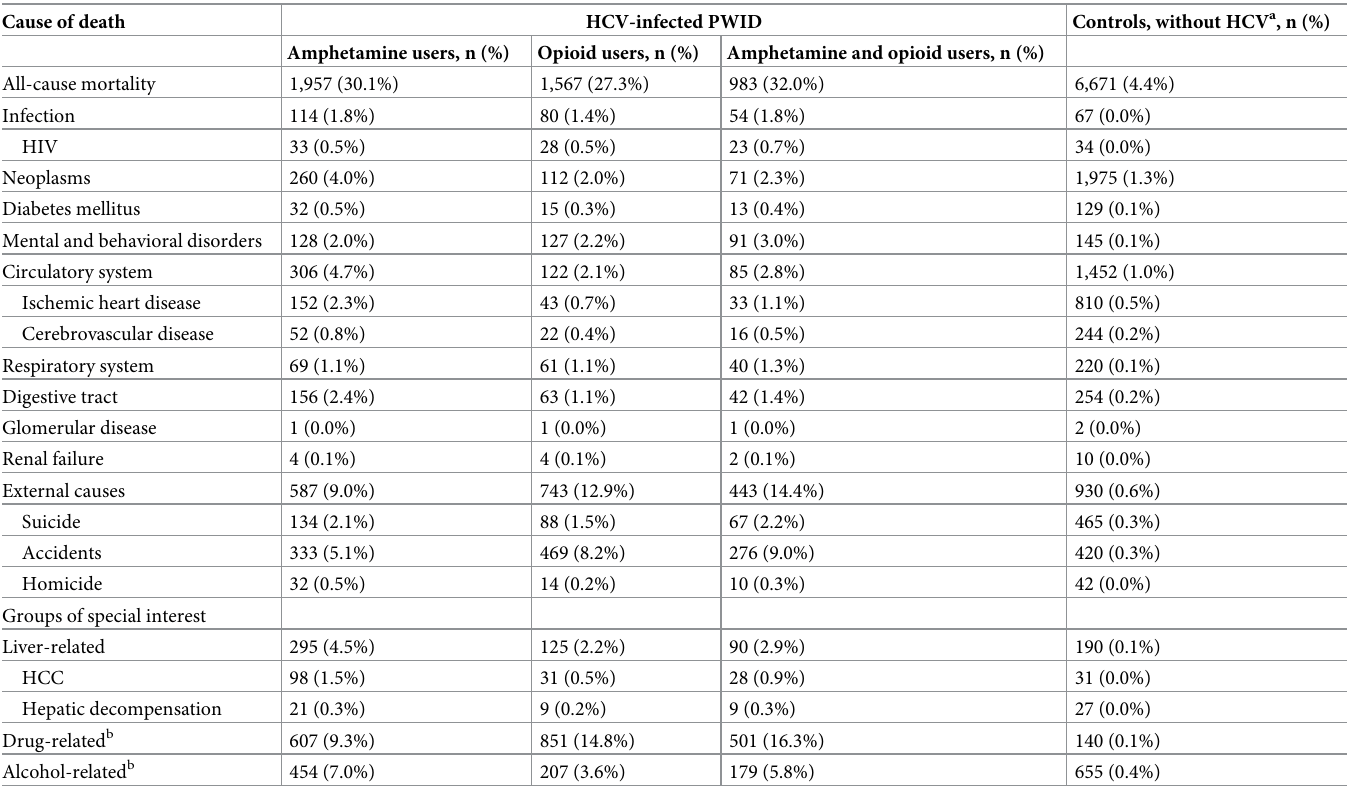
Table 2. Cause-specific mortality by hepatitis C status and substance